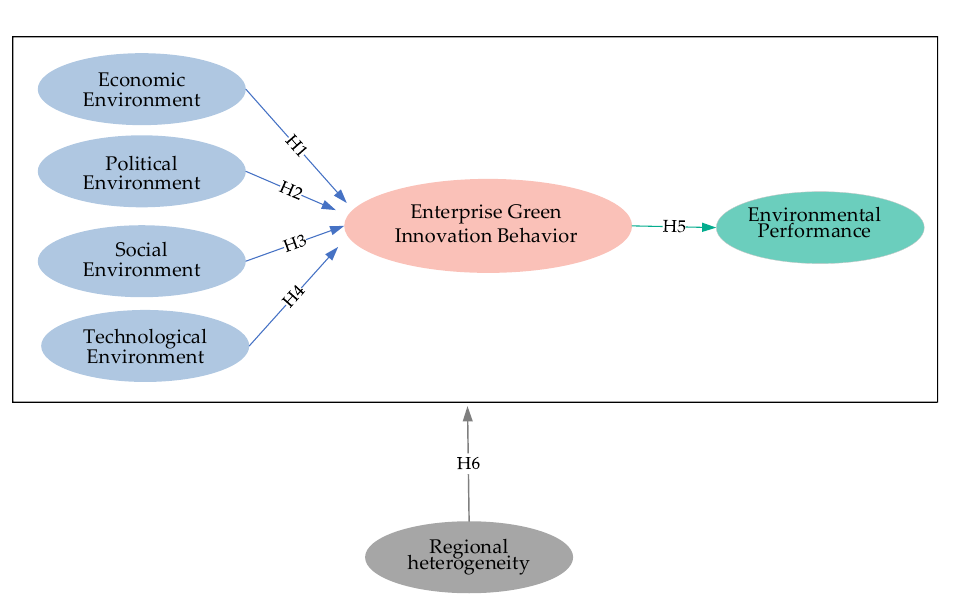
Figure 2. A hypothetical framework for enterprise green innovation behavior.